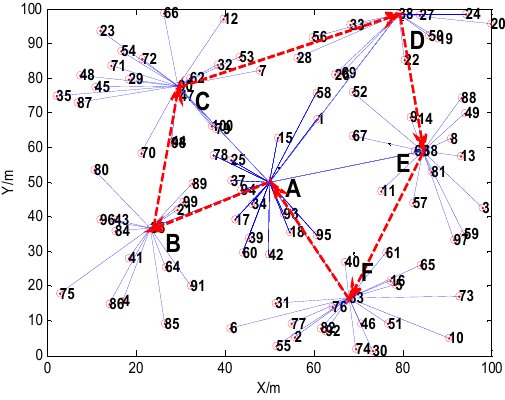
Figure 11. The result of route planning after considering the distance factor.